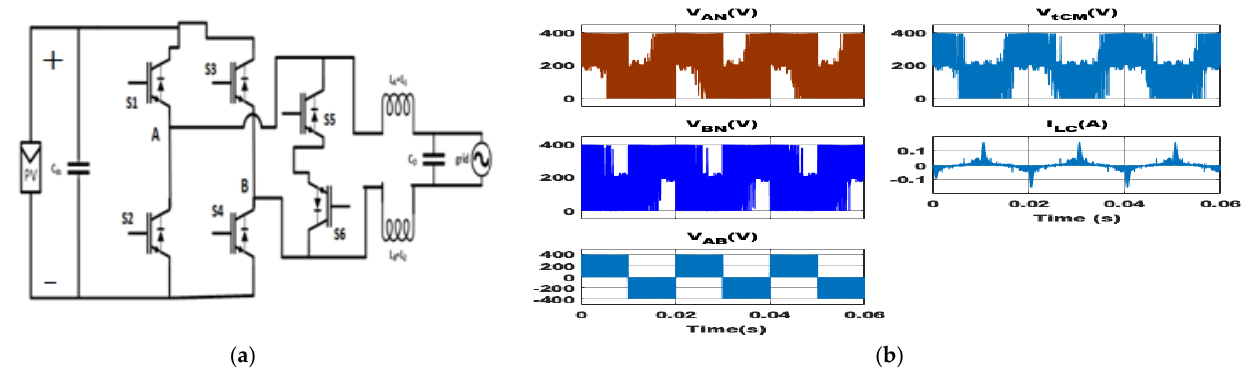
Figure 10. HERIC topology: ( a ) circuit structure; ( b ) simulation results.